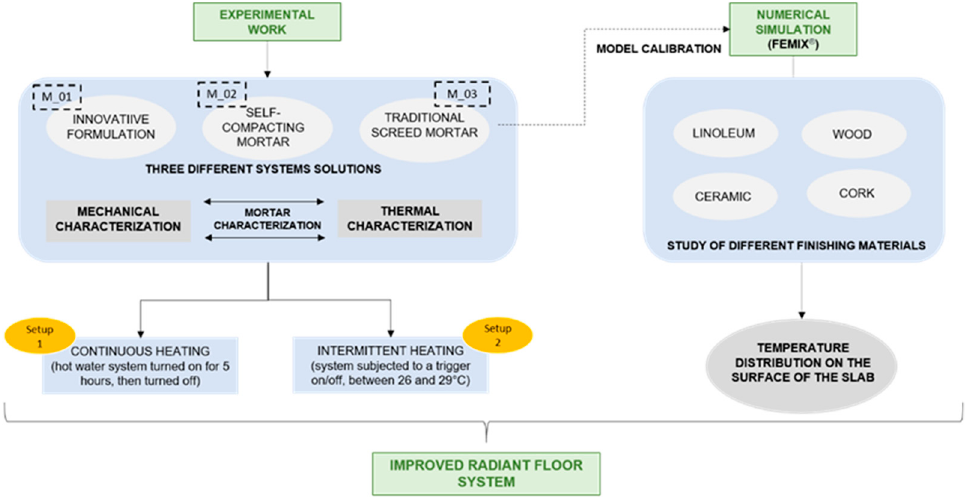
Figure 1. Methodology followed: thermal behaviour improvement of radiant floor systems.